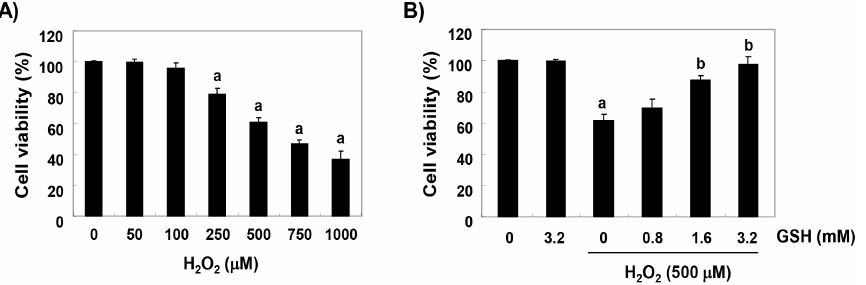
Figure 1. The protective effects of glutathione against the H 2 O 2 -induced cytotoxicity in RAW 264.7 cells. Cells were treated with ( A ) various concentrations of glutathione (GSH) for 24 h or ( B ) 500 μM H 2 O 2 for 24 h following a 1 h glutathione pre-treatment with the indicated concentrations. After treatment, cell viability was examined by MTT assay. Data were expressed as the mean ± SD of three